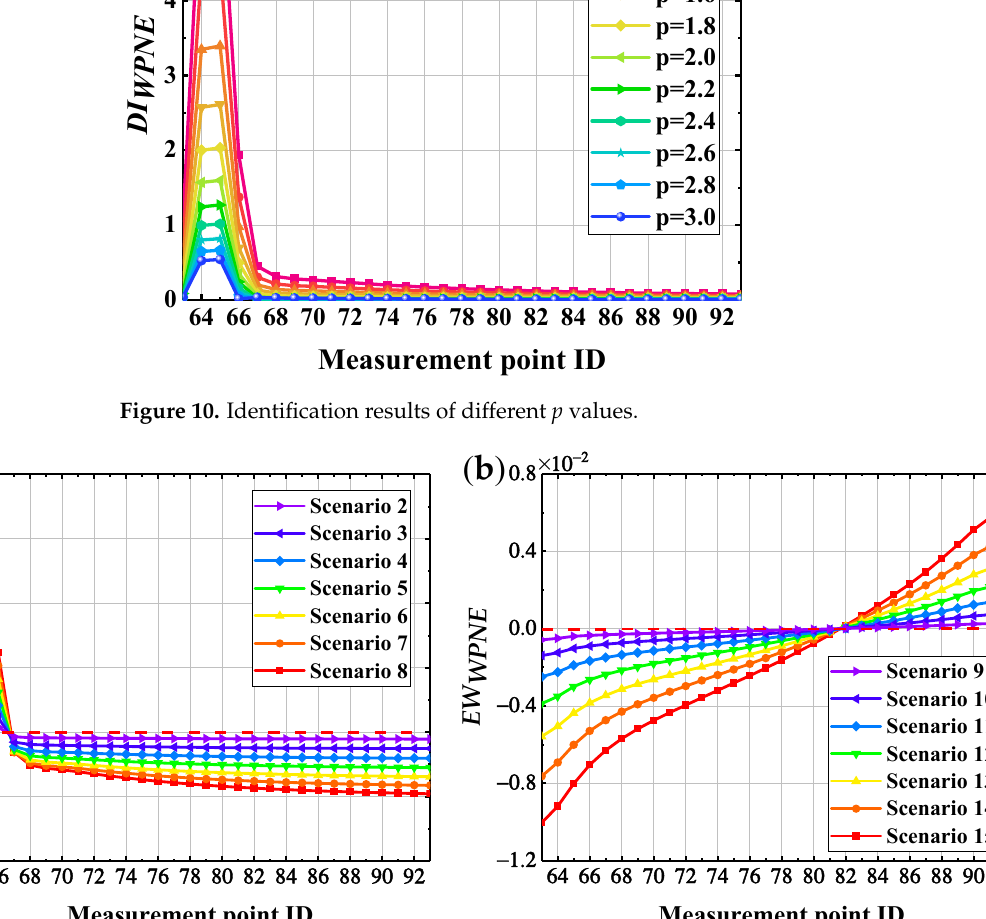
Figure 11. EW WPNE damage identification results: ( a ) damage I; ( b ) damage II.